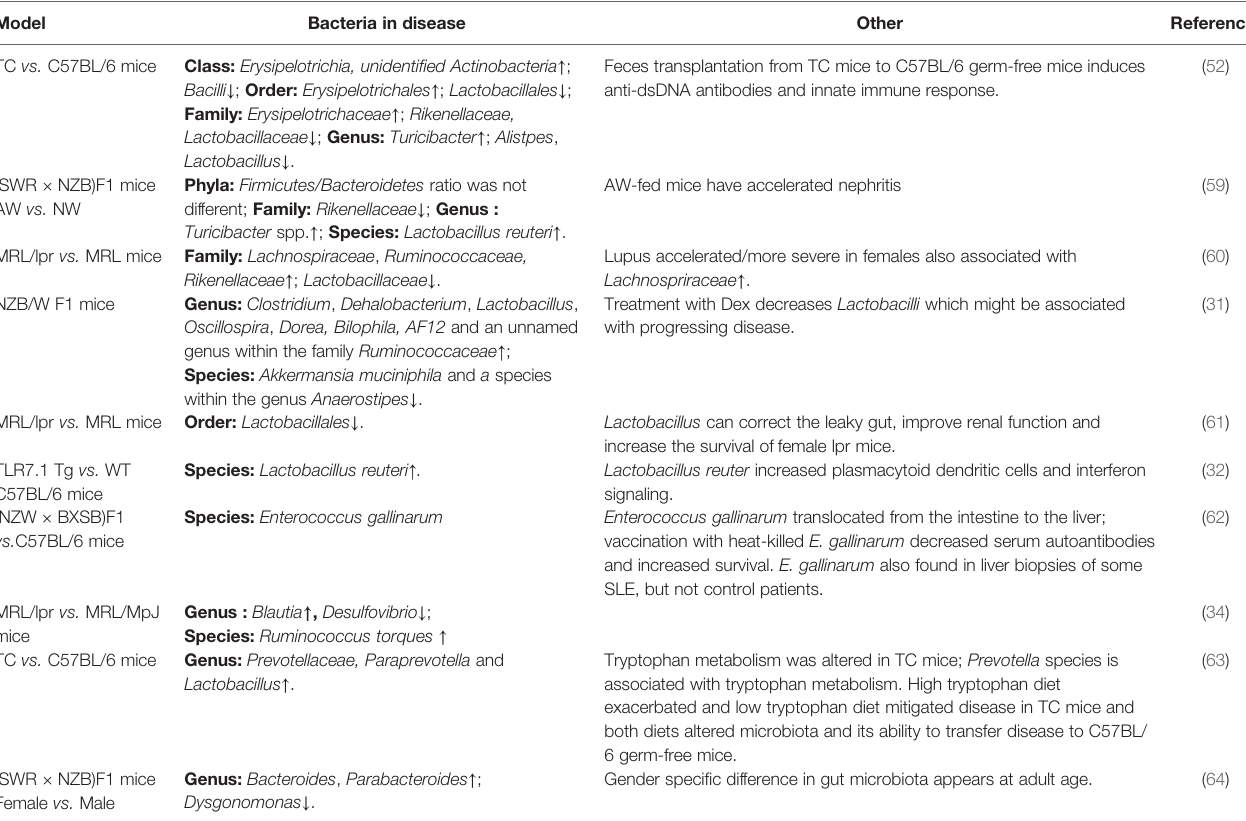
TABLE 2 | Microbiota alternation in lupus-related mouse models. Model Bacteria in disease Other